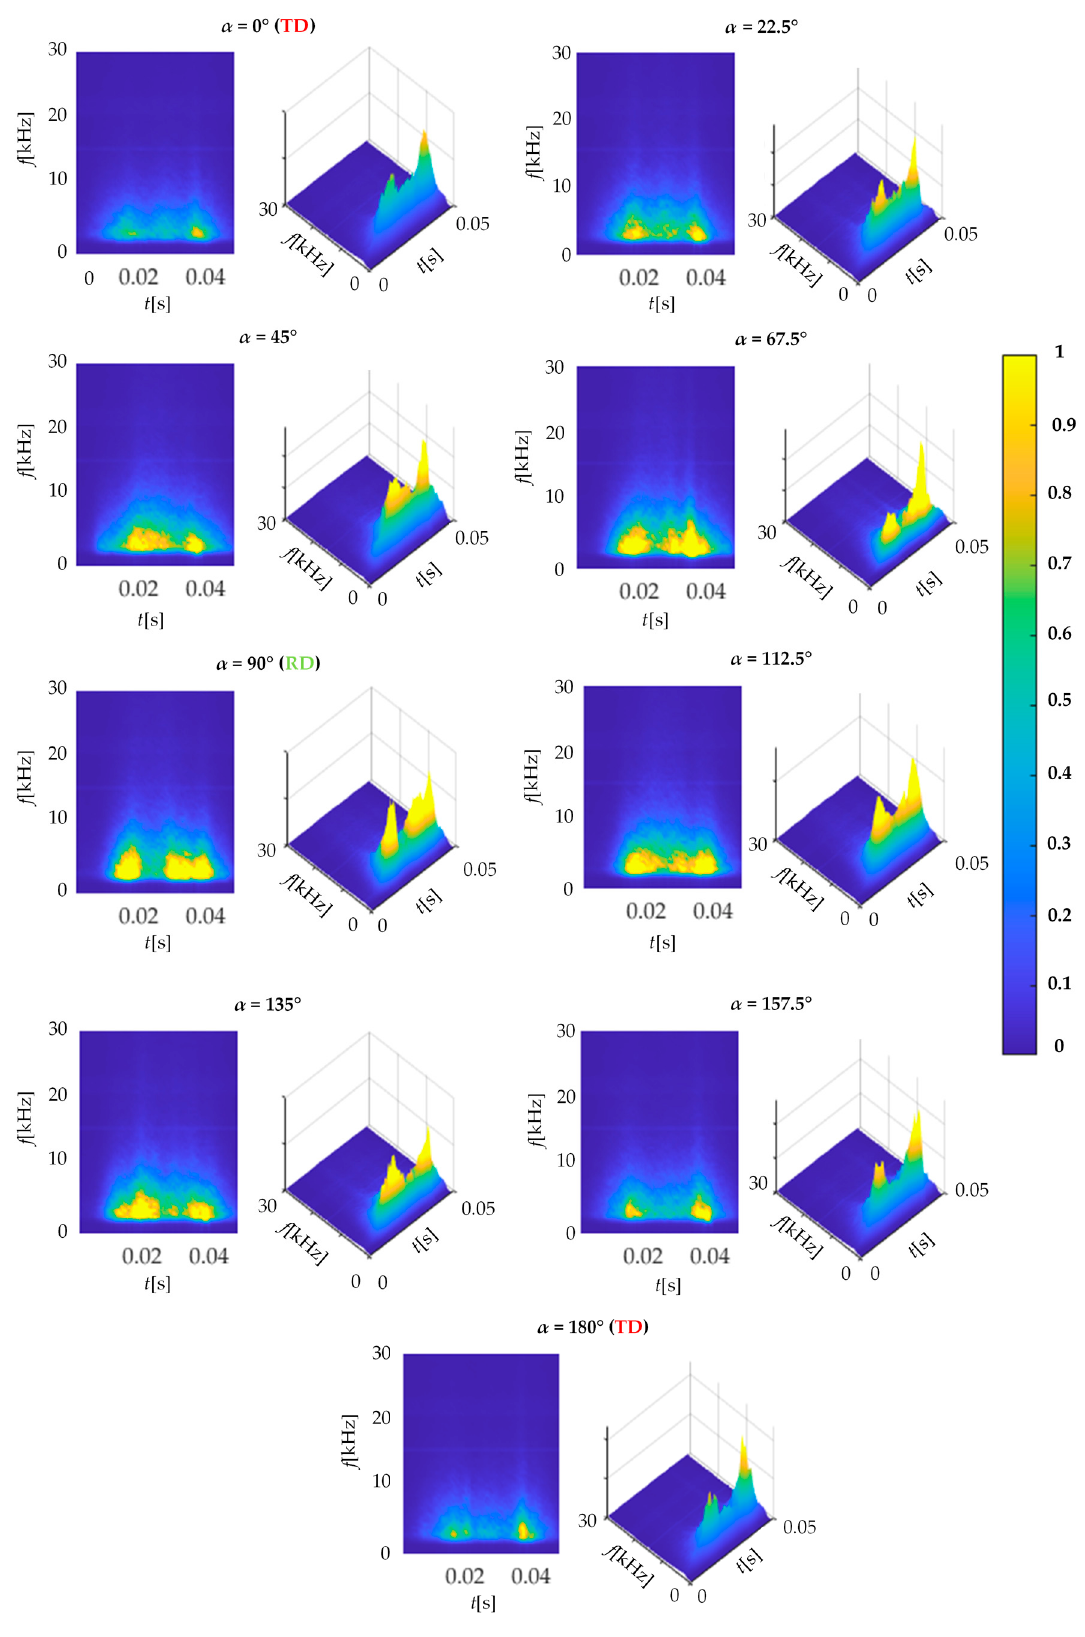
Figure 4. View of spectrogram activity in angle range between 0–180 degrees.